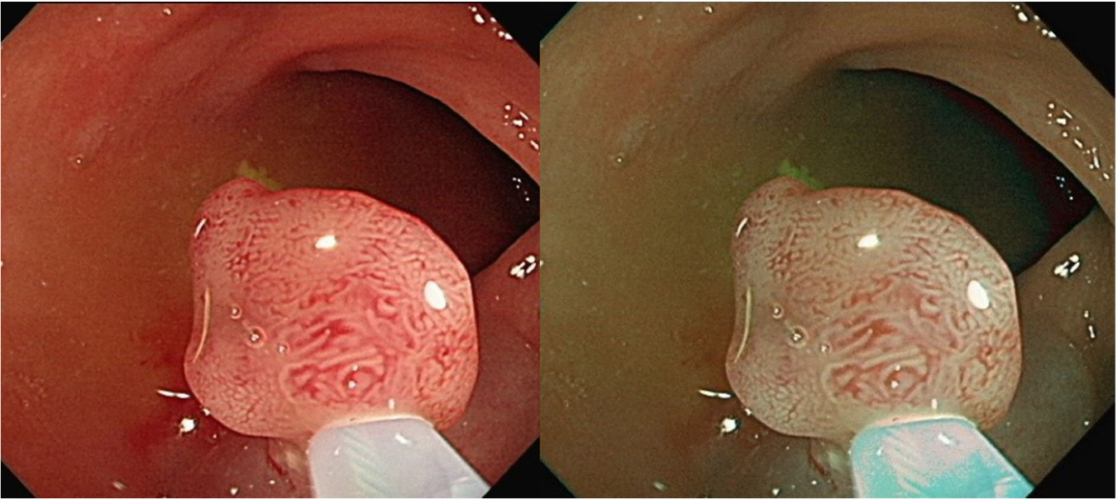
Figure 3. Images of TA polyps after Color Transfer with Mean Shift. (( Left ): Original WL, ( Right ): Color